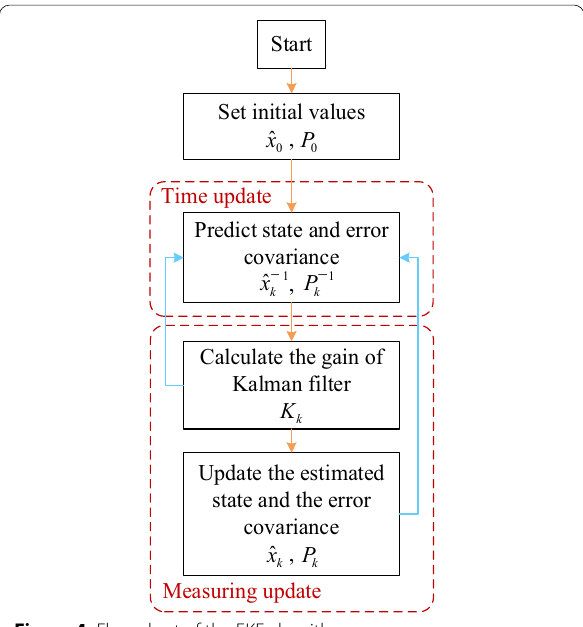
Figure 4 Flow chart of the EKF